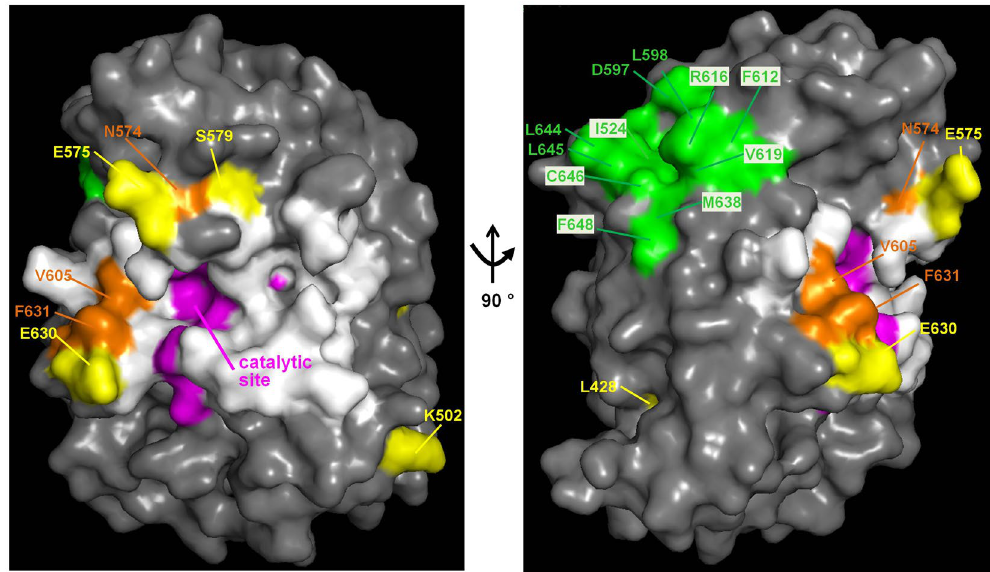
Figure 8. Mapping mutations and functional elements on a structural model of the C-terminal catalytic moiety of ScPpz1. The relevant mutations described in this work are highlighted in yellow and orange (as in Fig. 7). Residues involved in the catalytic mechanisms are pink, and the conserved hydrophobic groove, implicated in binding to RVxF-containing regulatory subunits, is denoted in green. Residues identical or similar to those involved in the interaction of mammalian PP1c with Inhibitor-2 α -helix described in the text are highlighted in white. Note that E 575 , V 605 , E 630 , and F 631 , as well as diverse residues in the catalytic site, although not depicted in white, are also involved in PP1c interaction with Inhibitor-2. The correspondence between the annotated residues and the clones recovered from the screen can be found in Tables 2 and 3.